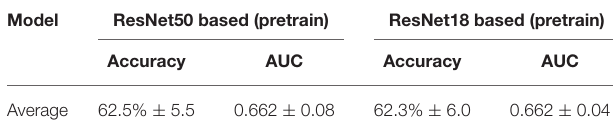
TABLE 4 | Prediction results of ReNet18 and ResNet50 based branch CNN. TABLE 5 | Comparison results of different